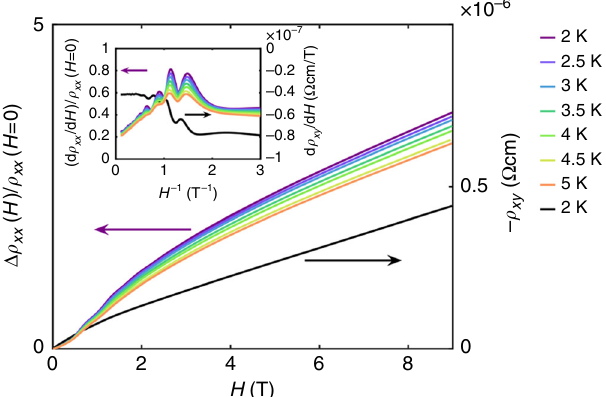
Fig. 1 Low fi eld Shubnikov – de Haas oscillations. Isothermal magnetoresistivity curves (left axis) and Hall resistivity (right axis) of a 1.2- nm-thick LTO fi lm on STO at 2 – 5 and 2 K, respectively. Oscillations are Fig. 2 High fi eld Shubnikov – de Haas oscillations. High fi eld isothermal